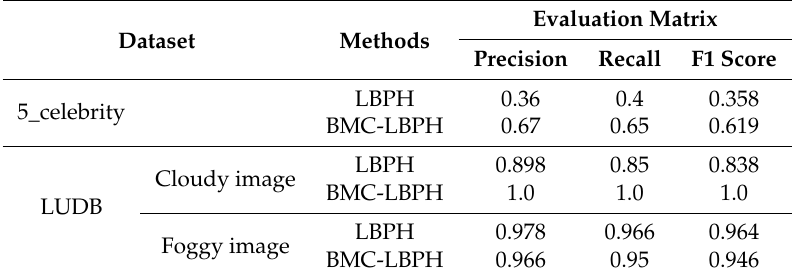
Table 4. Result comparison between LBPH and bilateral median convolution-Local binary pattern histogram (BMC-LBPH)